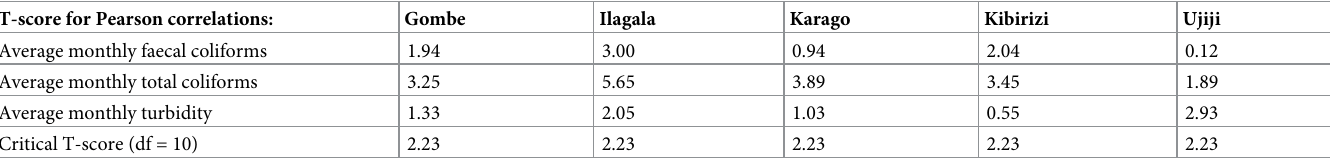
Table 5. Comparison of t-scores related to Pearson correlations comparing monthly dynamics of coliform and turbidity with monthly dynamics of precipitation for each study site. T-score for Pearson correlations: Gombe Ilagala Karago Kibirizi